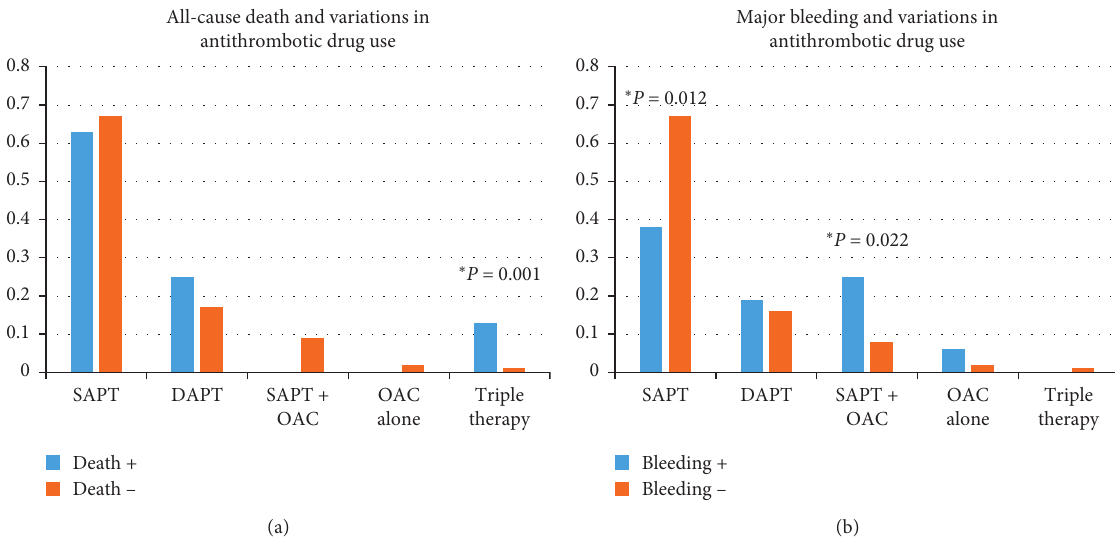
Figure 4: Variations in current antithrombotic drug use with or without all-cause death or major bleeding. DAPT: dual antiplatelet therapy; SAPT: single antiplatelet therapy; and OAC: oral